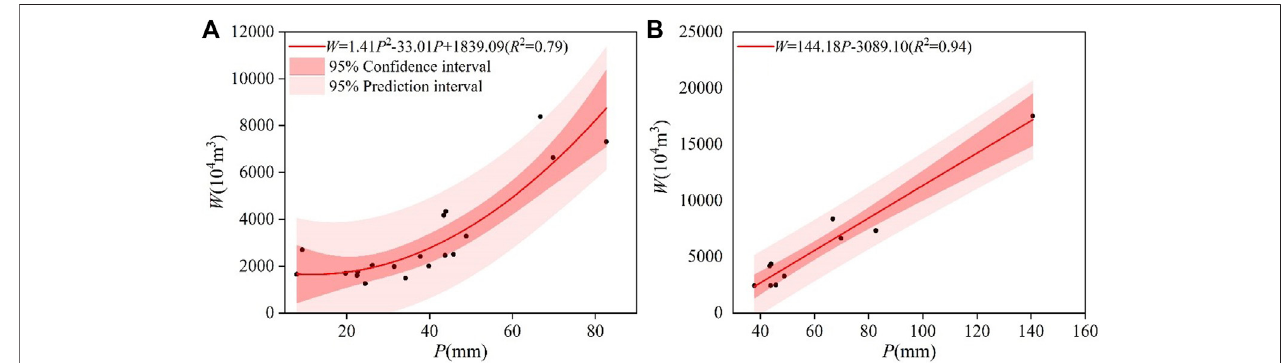
FIGURE 9 | Method of upper envelop: (A) for all rainfall; (B) for extreme rainfall events.